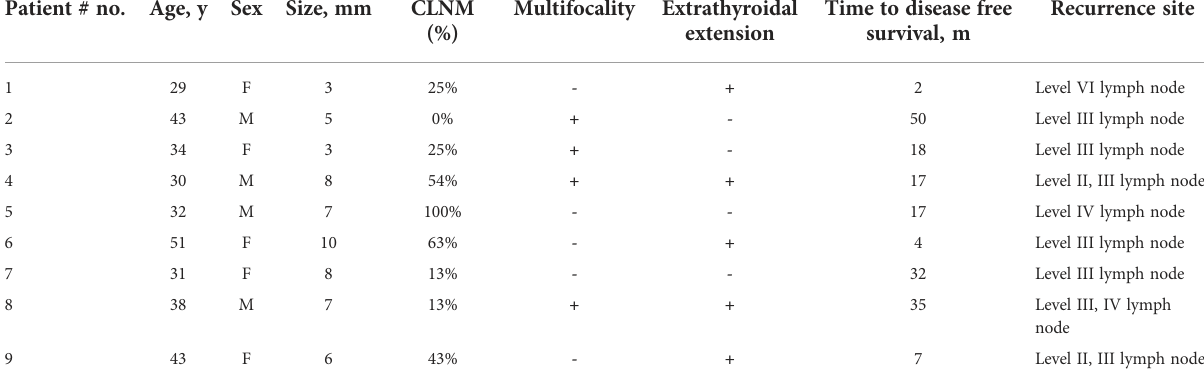
TABLE 3 Characteristics of the patients with tumor recurrence.